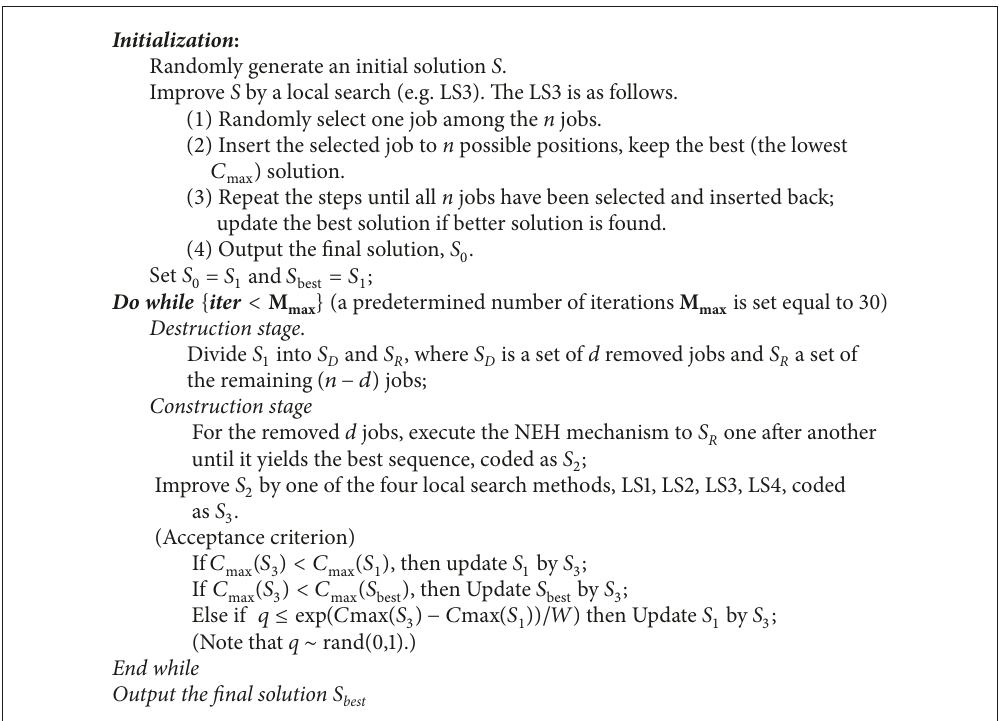
Algorithm 2: An IG algorithm,